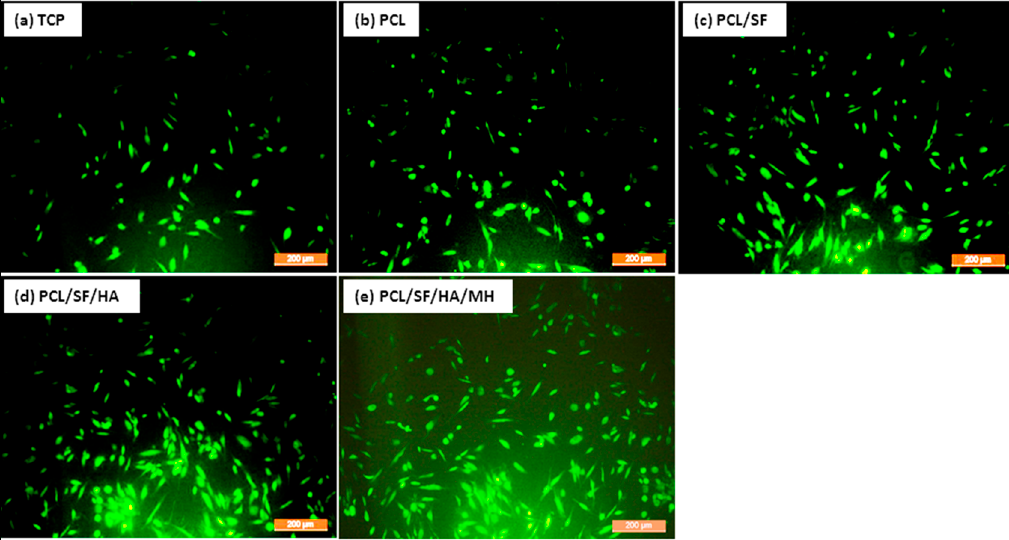
Figure 9. Cell morphology and 5-Chloromethylfluorescein diacetate CMFDA dye extrusion image to analyses the cell morphology on ( a ) TCP, ( b ) PCL ( c ) PCL/SF ( d ) PCL/SF/HA ( e ) PCL/SF/HA/MH micro/nanoparticles at 10× magnifications. The green color fluorescence indicate live cell morphology.